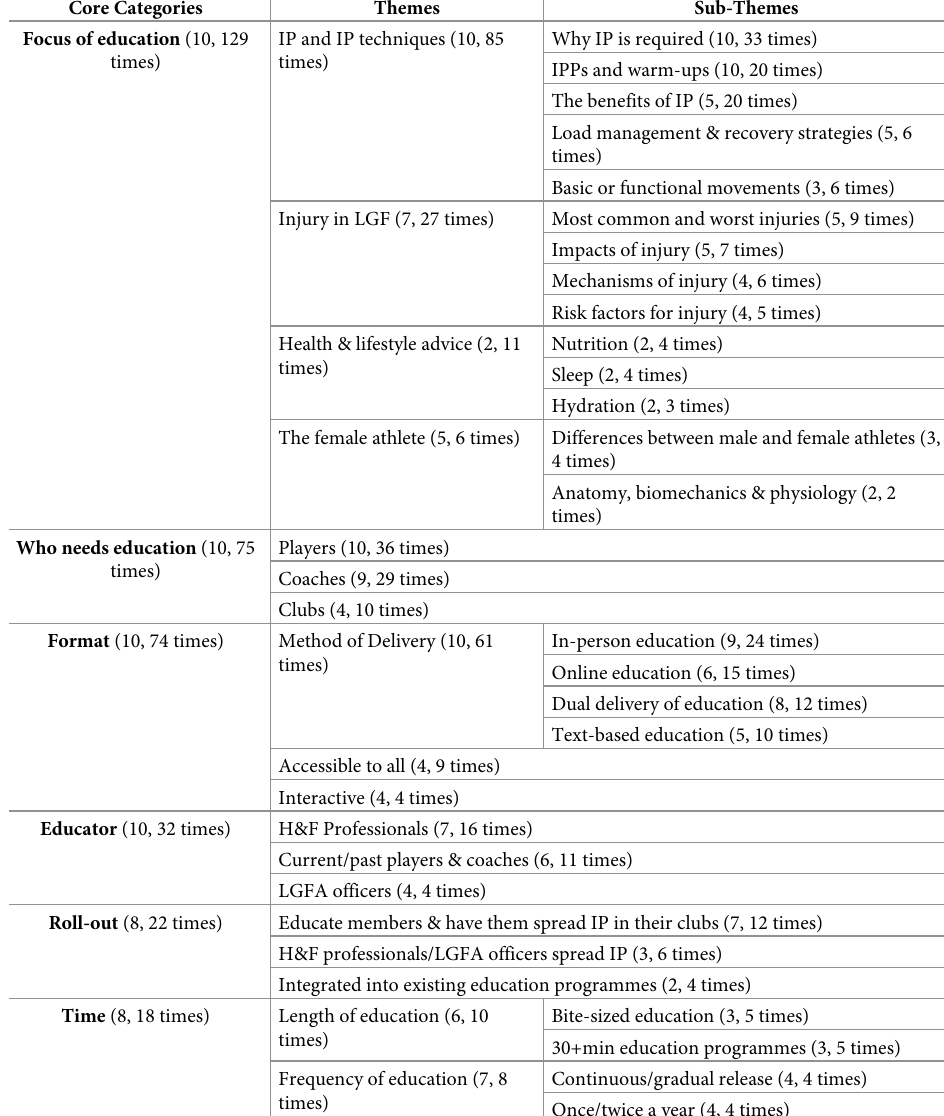
Table 4. Core categories, themes, and sub-themes surrounding players’ injury prevention education preferences (no. of players, no. of